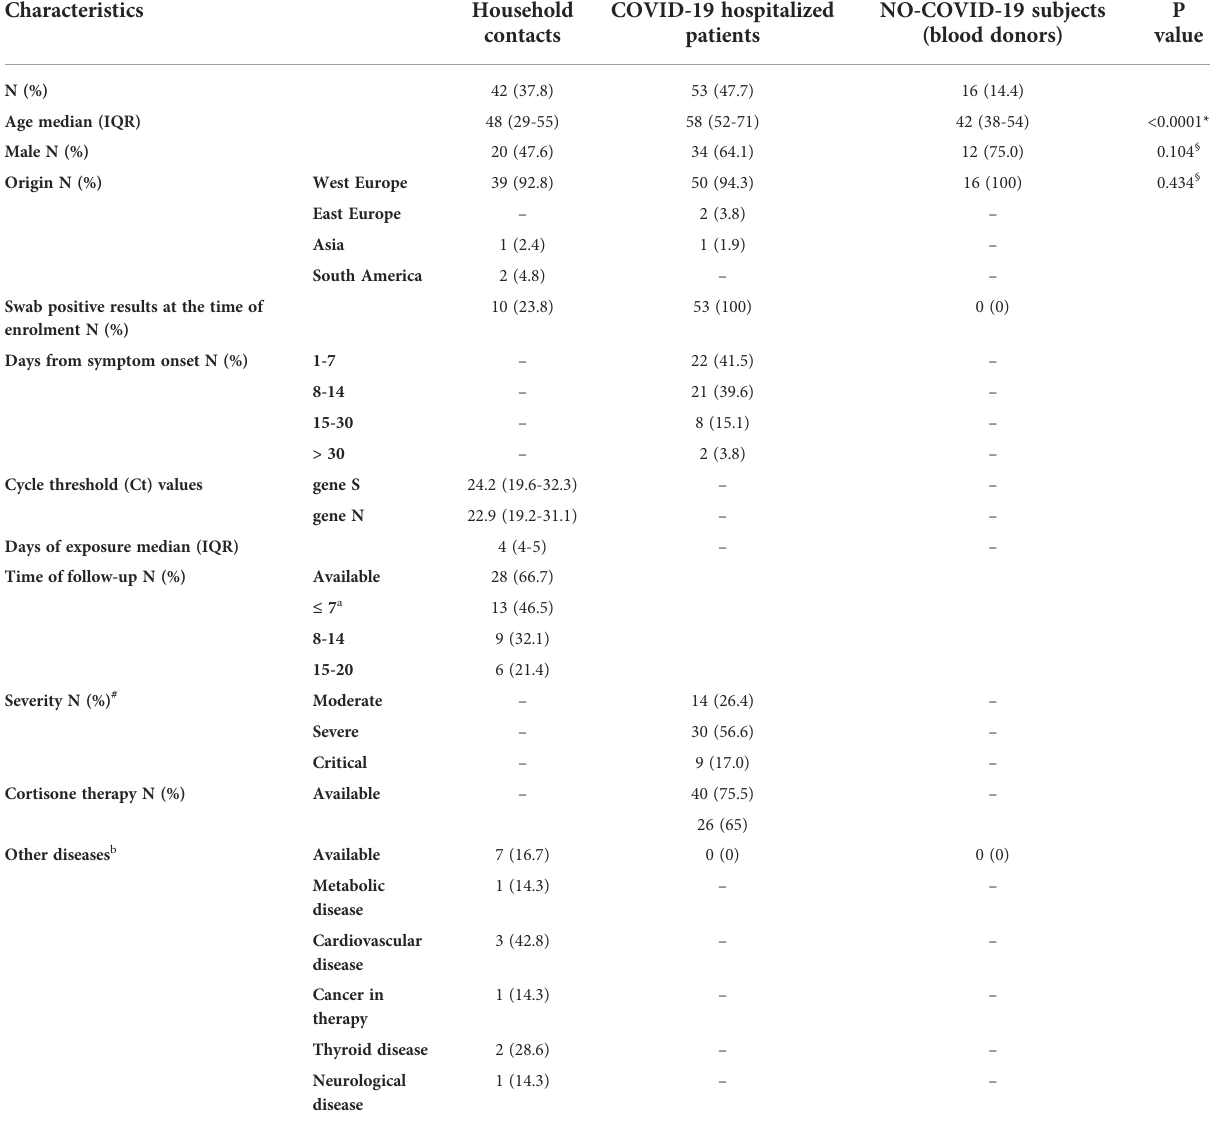
TABLE 1 Demographical and clinical characteristics of the 111 enrolled subjects.